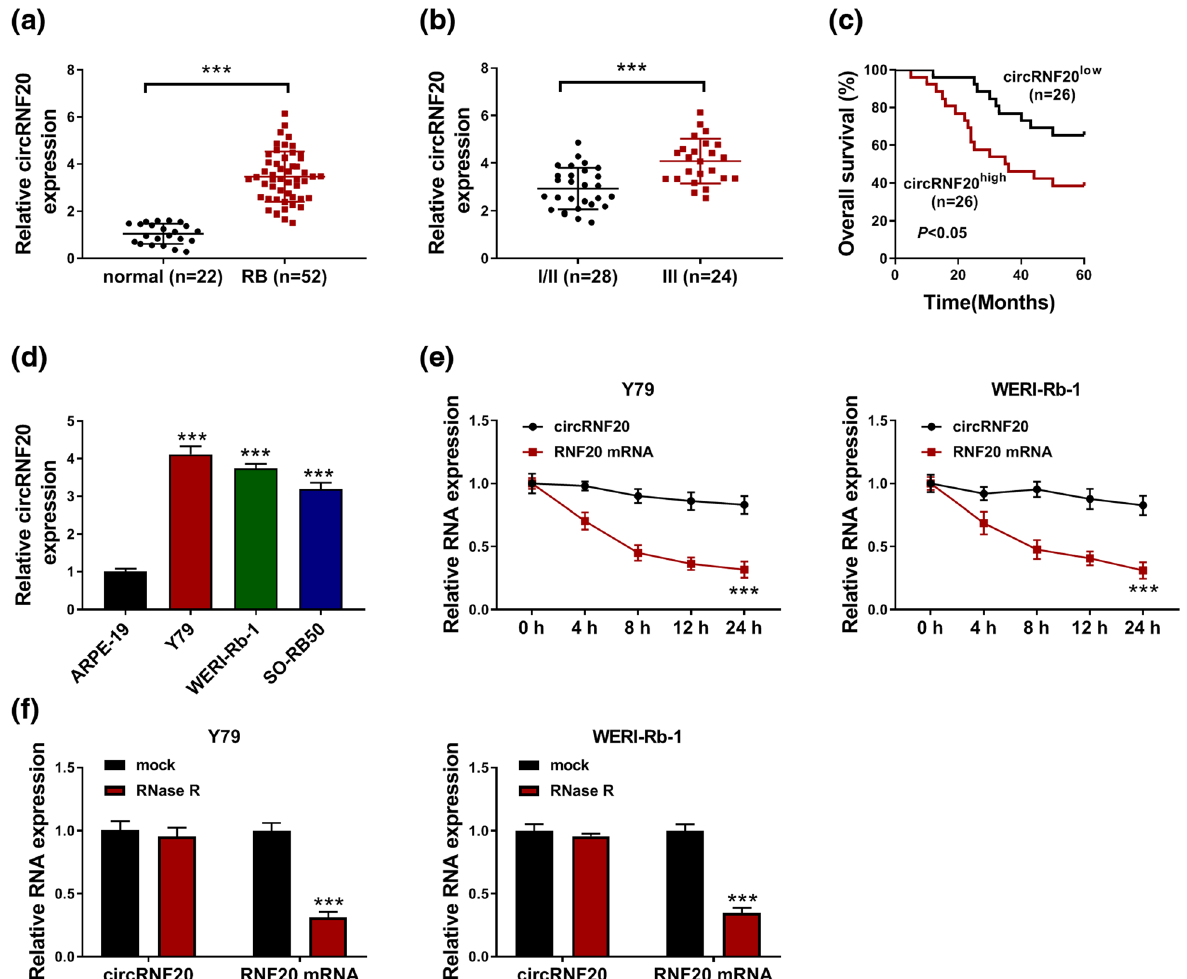
Figure 1: circRNF20 was increased in RB tissues and cells. ( a ) The expression of circRNF20 in RB tissues and normal tissues was detected by qRT - PCR assay. ( b ) The expression of circRNF20 in RB tissues at di ff erent TNM stages was detected by qRT - PCR assay. ( c ) The overall survival rate of RB patients in circRNF20 low and circRNF20 high groups was analyzed. ( d ) The level of circRNF20 in ARPE - 19, Y79, WERI - Rb - 1 and SO - RB50 cells was detected by qRT - PCR assay. ( e ) After Y79 and WERI - Rb - 1 cells were treated with actinomycin D for indicated times, the levels of circRNF20 and RNF20 mRNA were detected by qRT - PCR assay. ( f ) The levels of circRNF20 and RNF20 mRNA in Y79 and WERI - Rb - 1 cells treated with or without RNase R were detected by qRT - PCR assay. *** P <